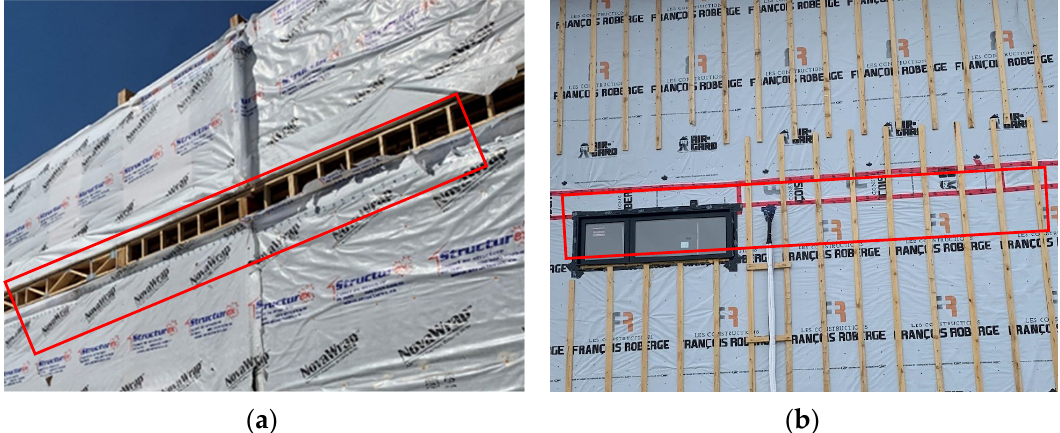
Figure 1. Junction of external walls with intermediate floor in a platform system prior to sealing ( a ) and after ( b ).